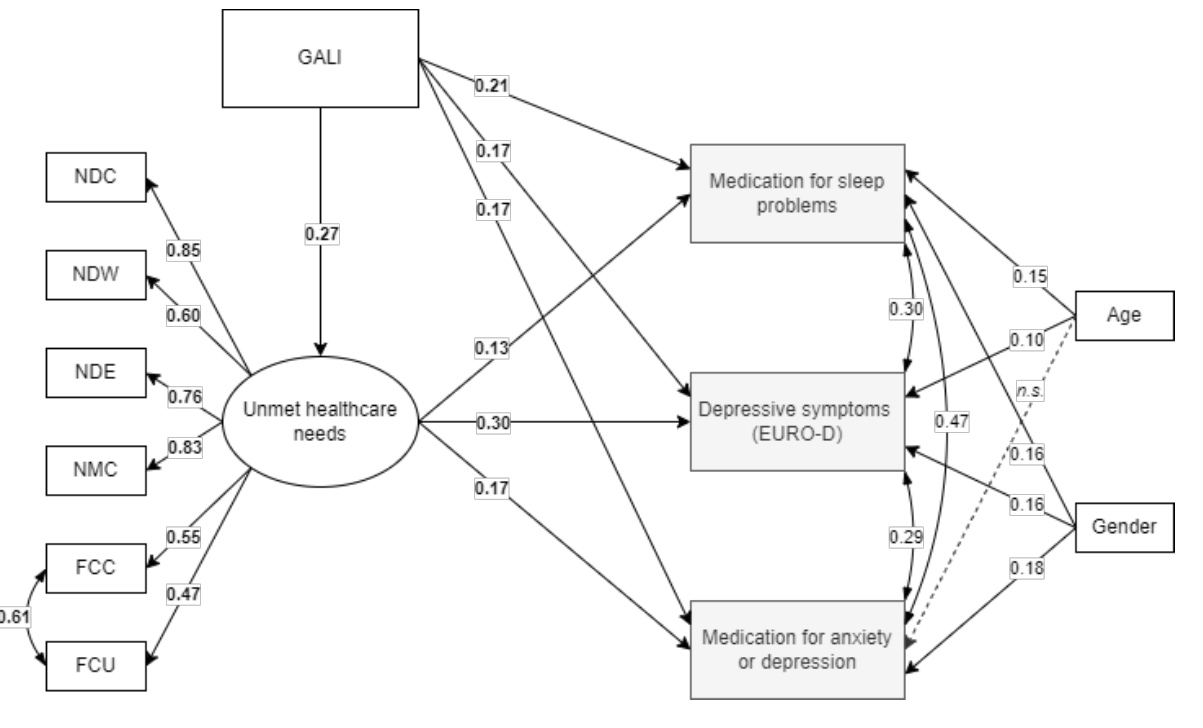
Figure 2. Final Model B results. Note. All estimates presented are significant at level p < 0.001. GALI, Global activity limitation index; NDC, didn’t see a doctor due to cost (lifetime); NDW, didn’t see